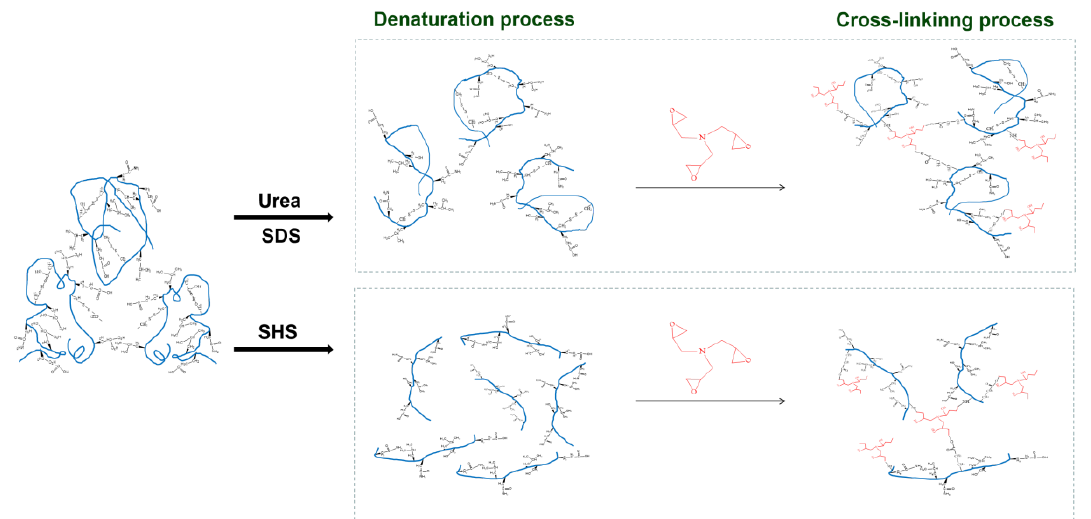
Figure 8. The denaturation and crosslinking mechanism of soy protein molecule. Figure 7. The denaturation and crosslinking mechanism of soy protein molecule.